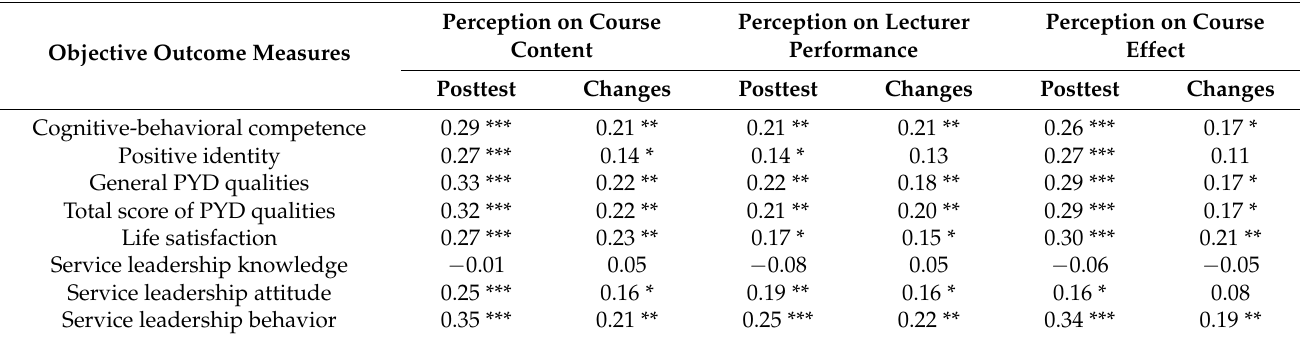
Table 6. Correlations between students’ subjective outcome evaluations and their posttest scores, as well as changes after taking the course (posttest score minus pretest score) (N =